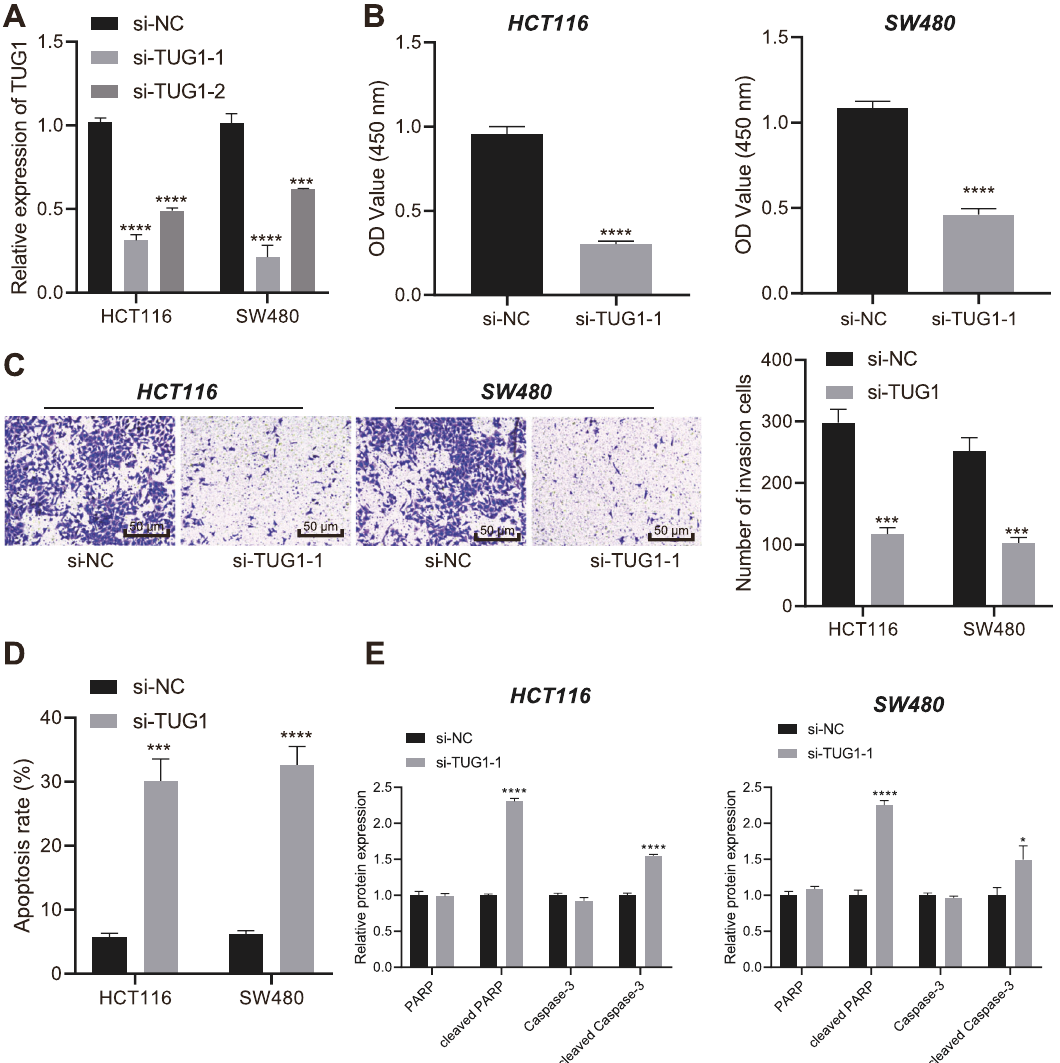
Fig. 2 TUG1 loss-of-function leads to suppression of CRC cell viability and invasion and promotion of cell apoptosis. A Determination of TUG1 expression in HCT116 and SW480 cells transfected with si-TUG1-1 and si-TUG1-2 by RT-qPCR. B – D Assessment of HCT116 and SW480 cell viability ( B ), invasion ( C ), and apoptosis ( D ) by CCK-8 assay, Transwell assay (200×) and fl ow cytometry, respectively following transfection with si-TUG1-1. E Western blot assay of PARP, cleaved PARP, Caspase-3, and cleaved Caspase-3 proteins in HCT116 and SW480 cells following transfection with si-TUG1-1. * p < 0.05, ** p < 0.01, *** p < 0.001 and **** p < 0.0001, compared with HCT116 and SW480 cells transfected with si-NC. The measurement data are expressed as mean ± standard deviation. The experiments were repeated three times independently.